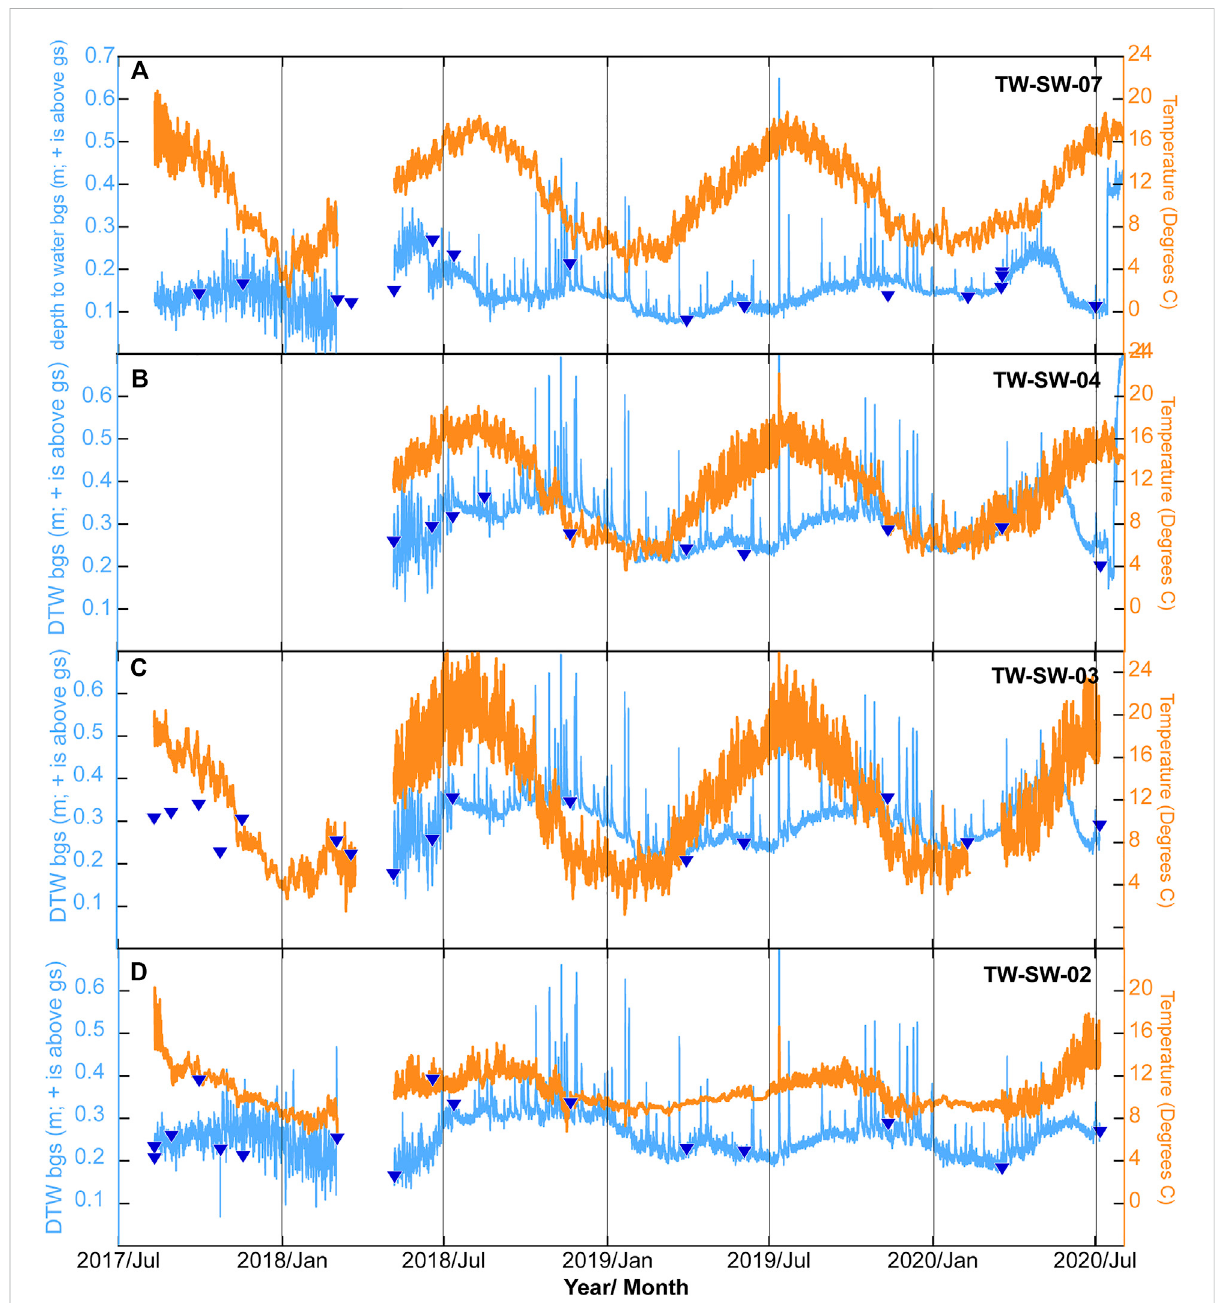
FIGURE 4 FoothillsPreservestreamsurfacewaterlevels(depthtowaterbelowgroundsurface,DTWbgs,[m]abovestreambedispositive,blue;symbols= measured) and temperatures ( ° C, orange) from upstream to downstream at Foothills Preserve: (A) TW-SW-07, (B) TW-SW-04, (C) TW-SW-03, and (D)